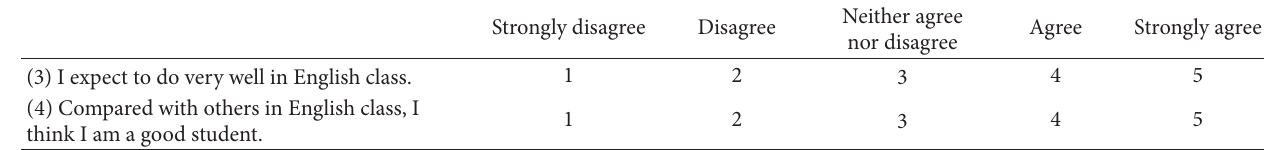
Table 2: Two example items of the Self-efficacy